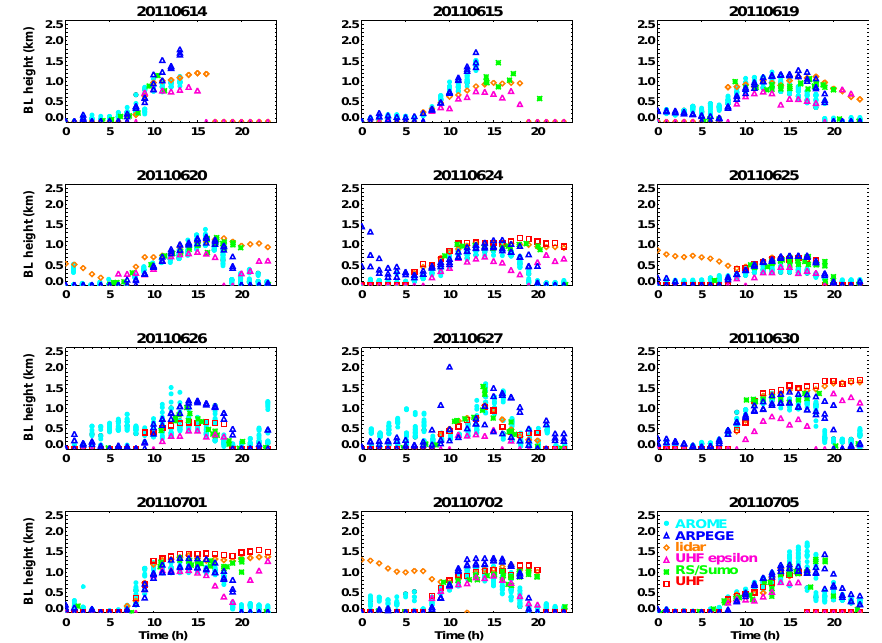
Figure 8. Time series of boundary-layer height observed by aerosol lidar (orange diamonds), UHF (from reflectivity in red squares and from the dissipation in pink triangles), radiosoundings or SUMO profiles (green stars) or simulated by ARPEGE (blue triangles) or AROME (cyan full circles) for each IOP. As indicated in the text, no value is drawn from ARPEGE and AROME after 14:00UTC on 14 and 15 June as the existence of clouds induce that the boundary-layer height diagnostic depicts in fact the top of the shallow